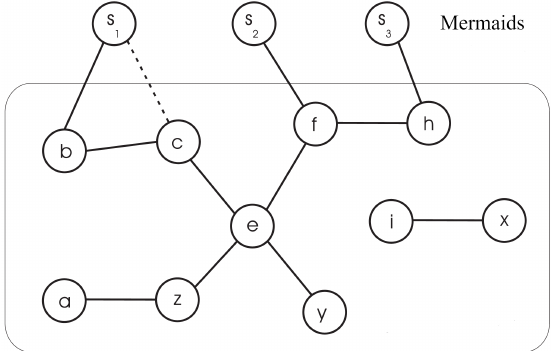
Figure 3. Example of online social network with normal users and mermaids V s = { s 1 , s 2 , s 3 } . Nodes inside the rounded rectangle belong to the users’ graph. Mermaids aim to connect to nodes of the users’ network in order to increase overall utilization (for instance edge ( s 1 , c )